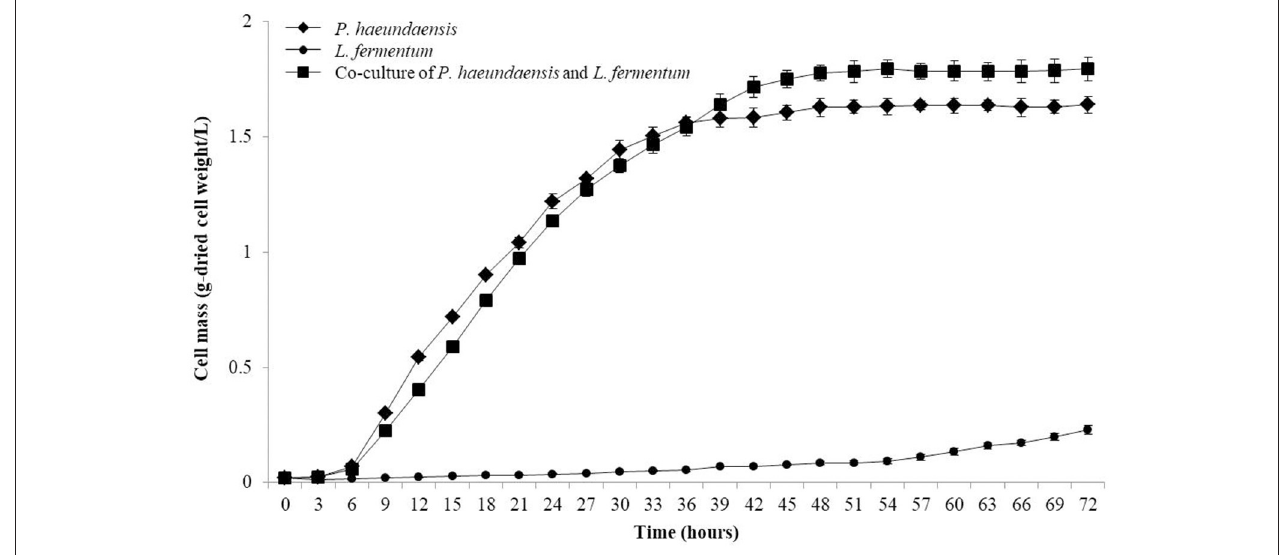
FIGURE 5 | Growth curve of P. haeundaensis single culture, L. fermentum single culture and co-culture of P. haeundaensis, and L. fermentum .